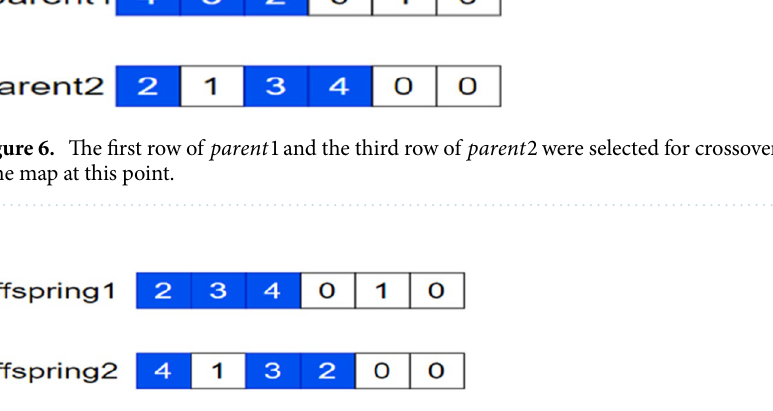
Figure 7. The first row of parent 1 and the third row of parent 2 are selected for crossover, at which point two offspring gene maps are